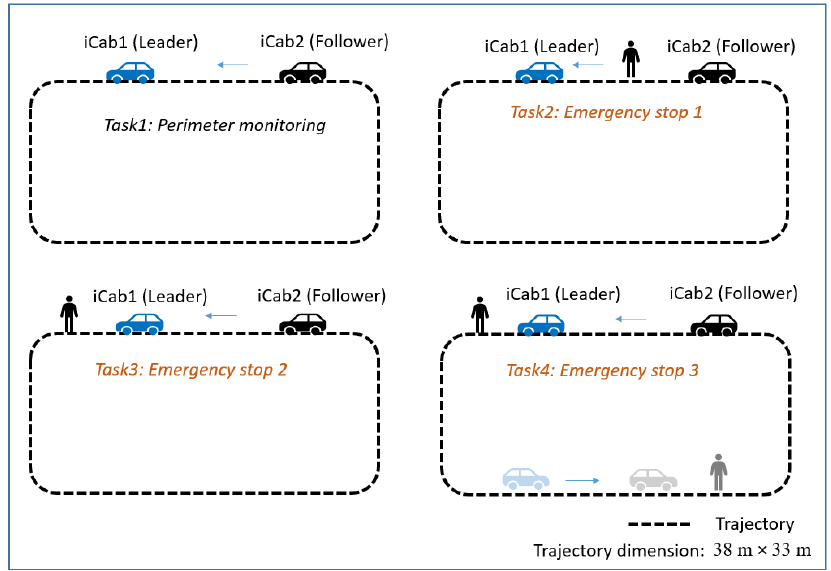
Figure 6. Co-operative driving tasks: The different co-operative driving scenarios considered. The datasets from Task 1 were used in the training phase to learn the model, and the remaining tasks (Task 2 to Task 4) were used in the test phase to check the model’s fitness in detecting local and global